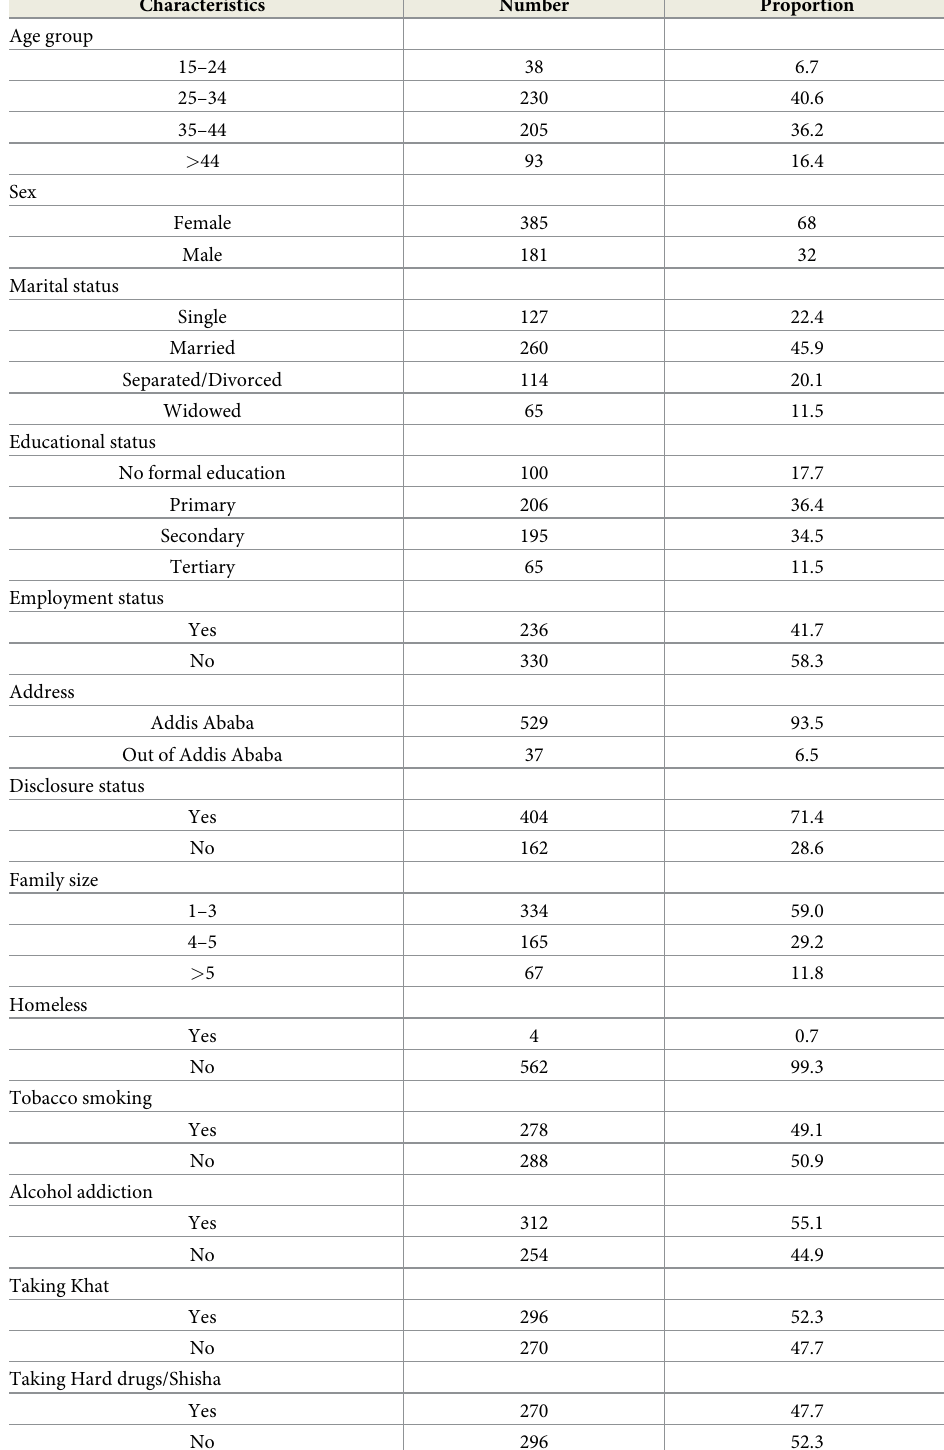
Table 1. Socio-demographic and behavioral characteristics among HIV positive patients in Addis Ababa, Ethio- pia, from 01 January 2013 up to 31 December 2018 (n = 566).